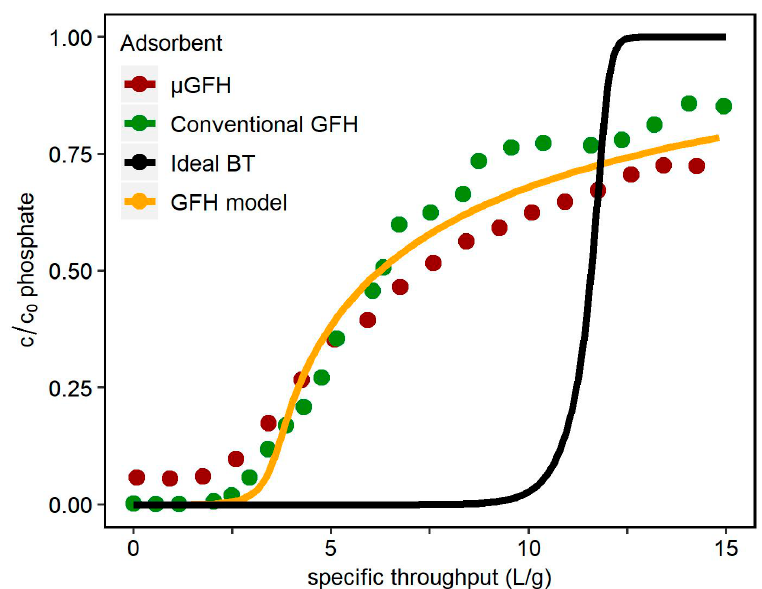
Figure 8. Phosphate breakthrough curve in embedded µ GFH (flow 2.2 m/h) compared to conventional GFH (3 m/h), modelled data (2.2 m/h) and the ideal breakthrough curve without surface diffusion limitation (pH 7, buffered, c 0 (P) = 2 mg/L).